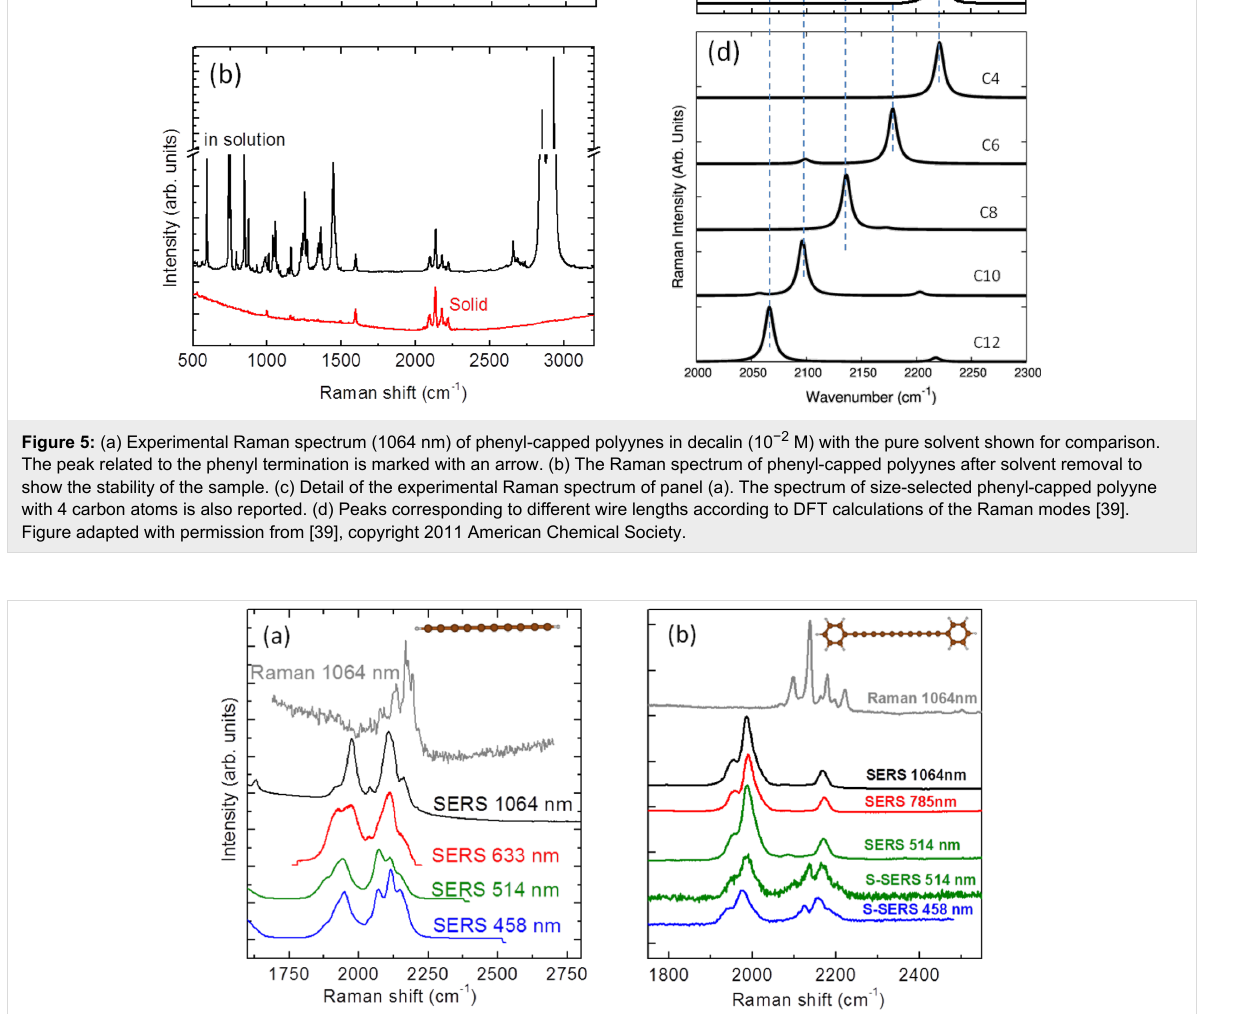
Figure 6: Raman and SERS spectra of H-capped (a) and phenyl-capped (b) polyynes in solution at different excitation wavelengths. SERS on solid surfaces (S-SERS) of phenyl-capped polyynes are also reported. The Raman spectra (at 1064 nm) of both systems are shown for direct comparison. Figure adapted with permission from [39], copyright 2011 American Chemical